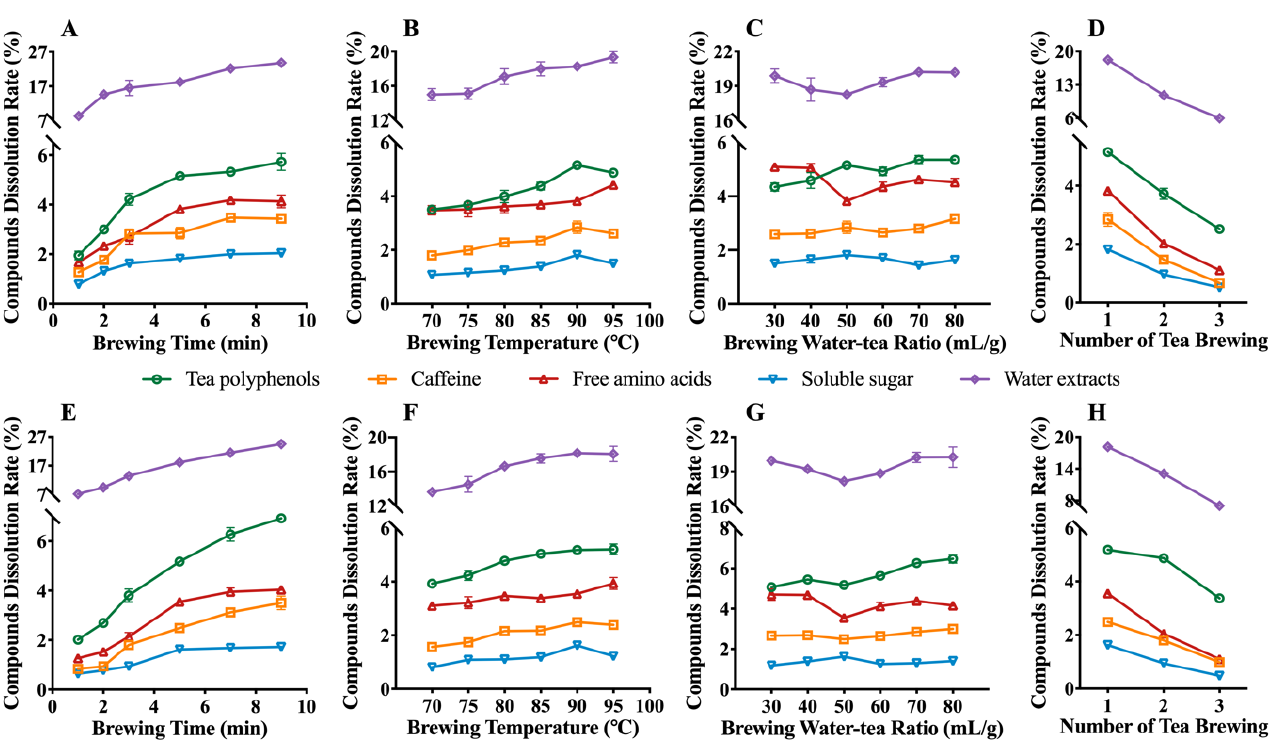
Figure 1. Effects of brewing conditions on the dissolution rate of the phytochemical compositions of tea infusions for ESYL ( A – D ) and ZYMJ ( E – H ). Data are shown as mean ± SD from the triplicate analysis.